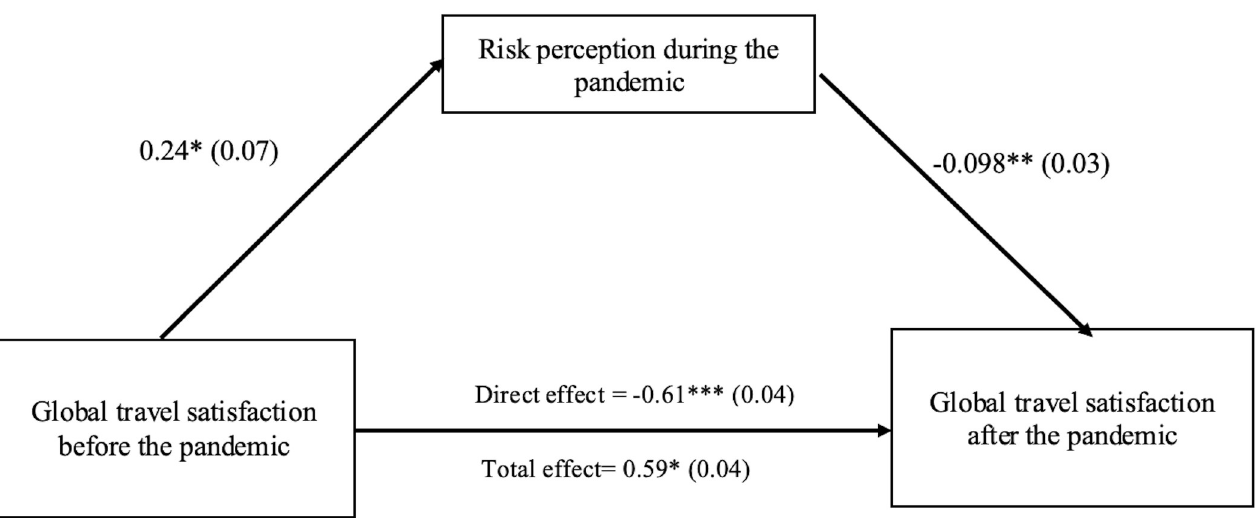
Fig 3. The conceptual model proposed to account for the relationship between global STS before the pandemic and global STS after the pandemic with the mediation effect of risk perception during the pandemic. Data values are unstandardized β regression coefficients, with standard errors shown in parentheses. p < .05 � , p < .01 � � , p < .001 ��� (two-tailed test).